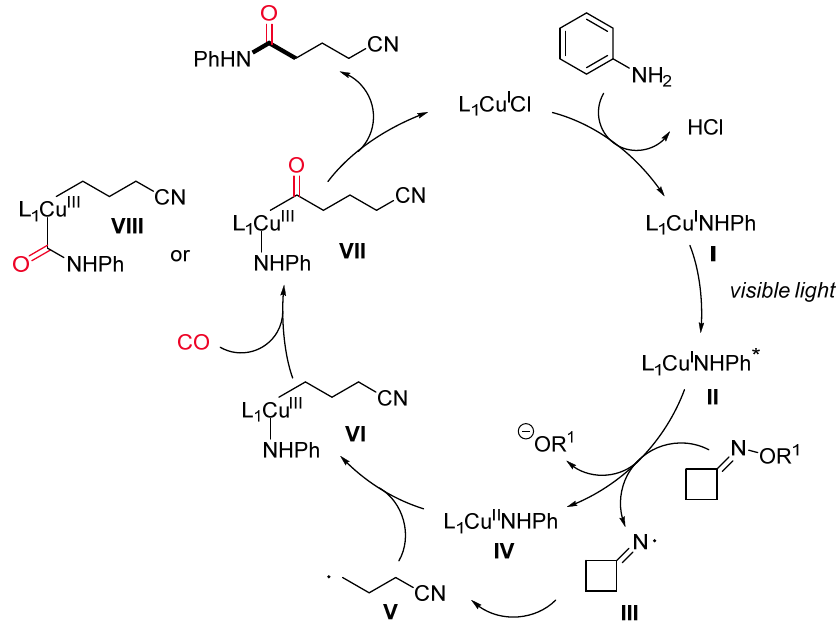
Scheme 36. The proposed reaction